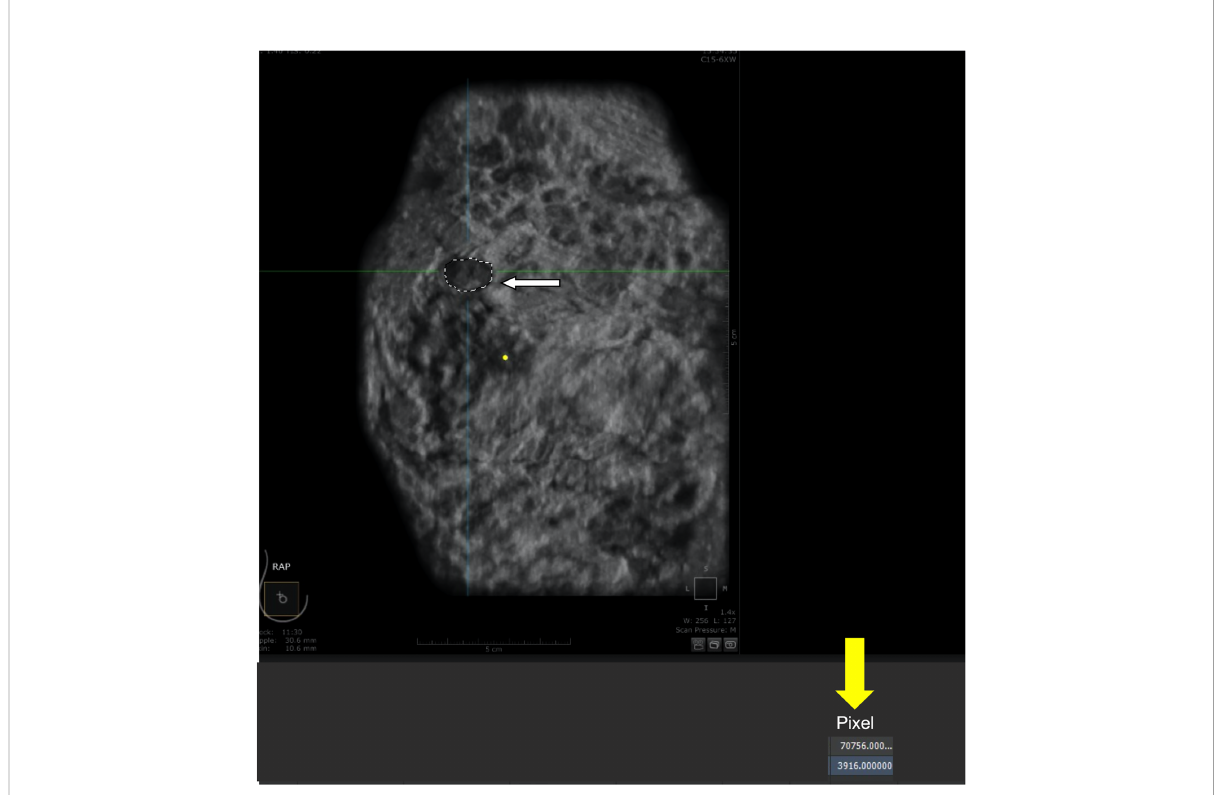
FIGURE 2 Calculation of pixels within the tumor. (A) tumor (outlined by white dashed line). (B) number of pixels (3916) automatically counted by the software within the outlined region.